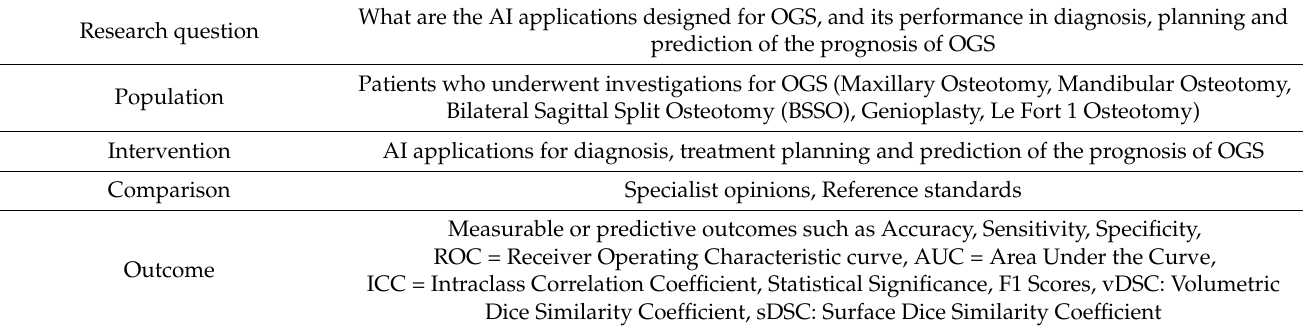
Table 1. Description of the PICO (P = Population, I = Intervention, C = Comparison, O = Outcome)